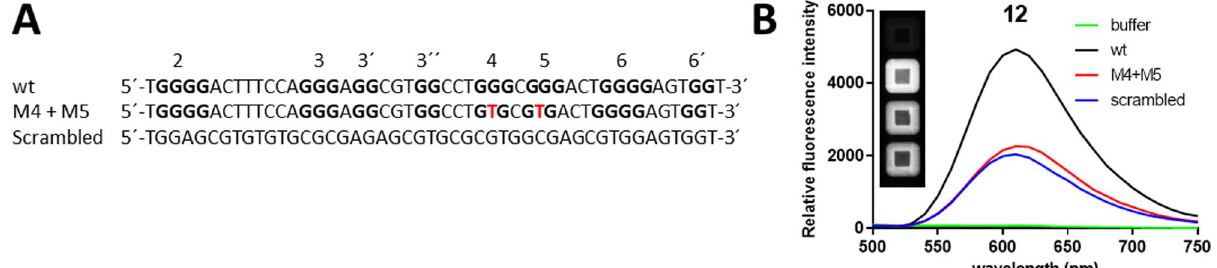
Figure 6. Light-up experiment. ( A ) Sequences of oligonucleotides used in the light-up experiment with the G bases involved in the formation of G-quadruplexes in bold and the G-tracts numbered. The abbreviation ‘wt’ indicates the LTR oligonucleotide with a wild-type sequence capable of folding into G-quadruplex structures. ‘M4 + M5’ indicates the LTR oligonucleotide with two point mutations (highlighted in red) that is unable to form G-quadruplexes. ‘Scrambled’ is the labelling of the LTR oligonucleotide with the identical base composition as the wild-type oligonucleotide, but with a scrambled sequence. ( B ) Emission spectra of 12 after incubation with different oligonucleotides or the reaction buffer alone after excitation at 280 nm. The inset represents a fluorescent image of the wells with compound 12 and a given oligonucleotide after UV-light excitation taken with the Bio-Rad ChemiDoc imaging